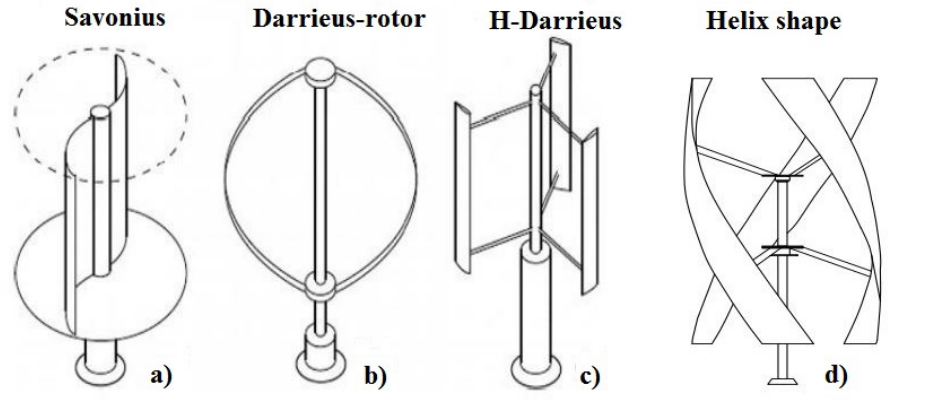
Figure 1. Different kinds of vertical axis wind turbines (VAWT): ( a ) Savonius; ( b ) Darrieus with “egg beater” design rotor; ( c ) H-shape blades; ( d ) helix shape